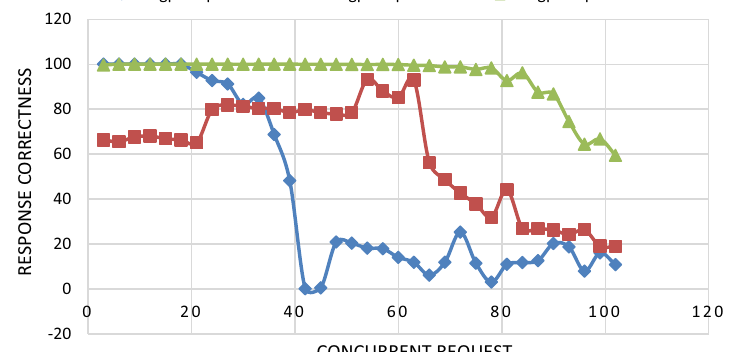
Fig. 5 Success rate % based on the concurrent request for 2 GPUs